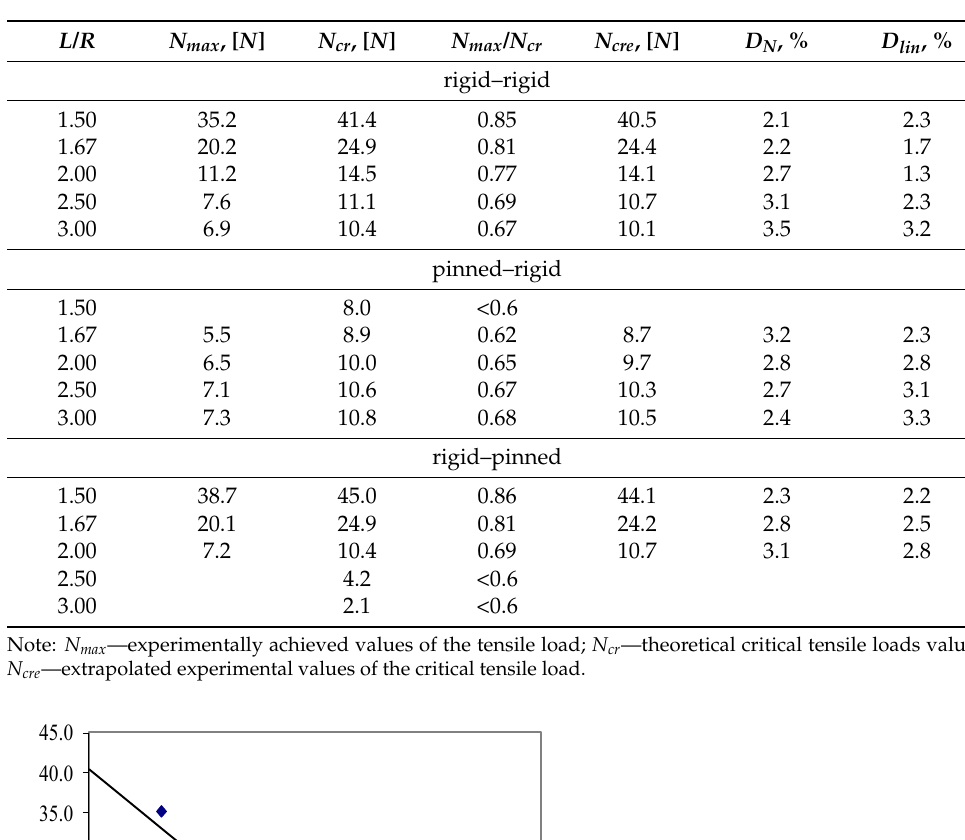
Table 3. Maximal experimental and theoretical values of the tensile load and extrapolated experi- mental values of critical tensile loads for different L/R ratios.